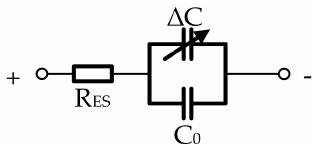
Figure 1. Simplified capacitor circuit model of the SC unit.